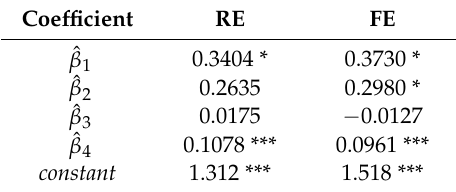
Table 2. Estimating the impact of sending/receiving the token and past behavior on contributions.